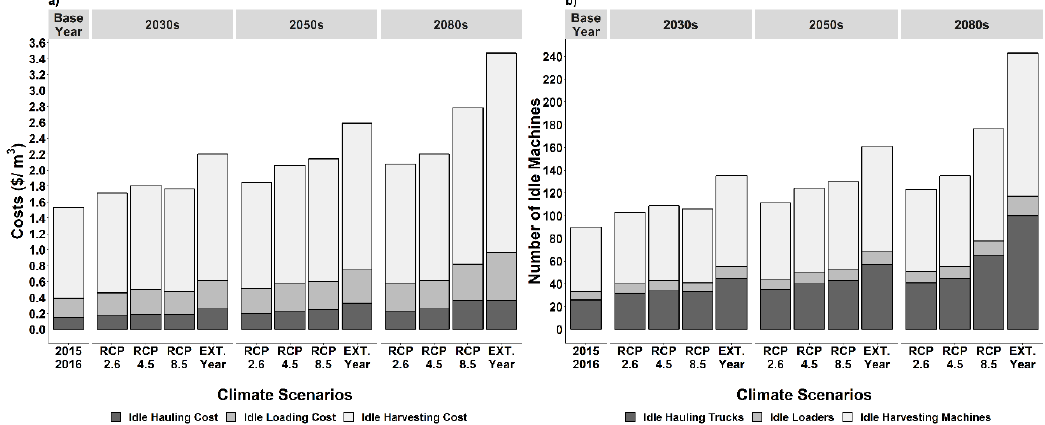
Figure 3. Analysis of idle logging equipment when logs were hauled only directly to the mill in winter, under di ff erent climate scenarios in several di ff erent times in the future; ( a ) total costs of idle machines; ( b ) total number machines that are idle in summer months. Sundays and holidays were subtracted from the available time for operations .